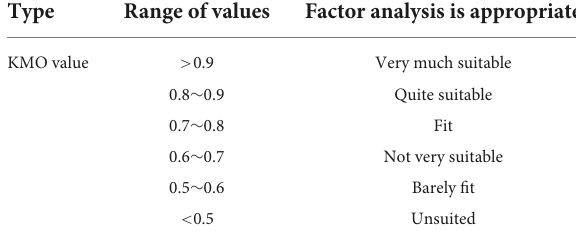
TABLE 1 Kaiser Meyer Olkin test